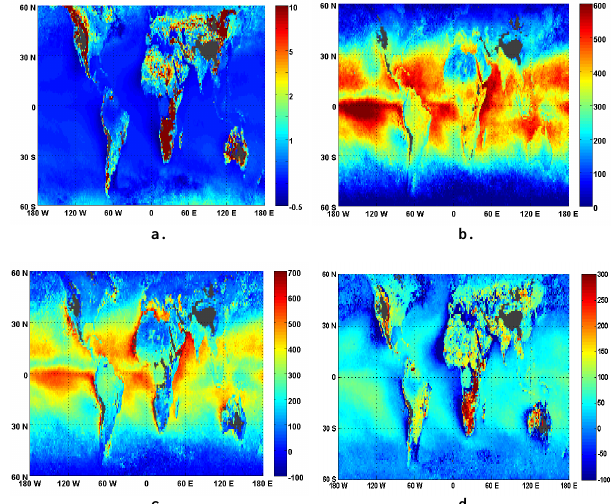
Figure 1. Global fields of yearly average 13:30 derived from AIRS sounder observations for 2003. (a) Bowen ratio β (Wm − 2 / Wm − 2 ). (b) Net available energy, (cid:56) (Wm − 2 ). (c) Latent heat flux, λE (Wm − 2 ). (d) Sensible heat flux, H (Wm − 2 ). Missing data are marked in